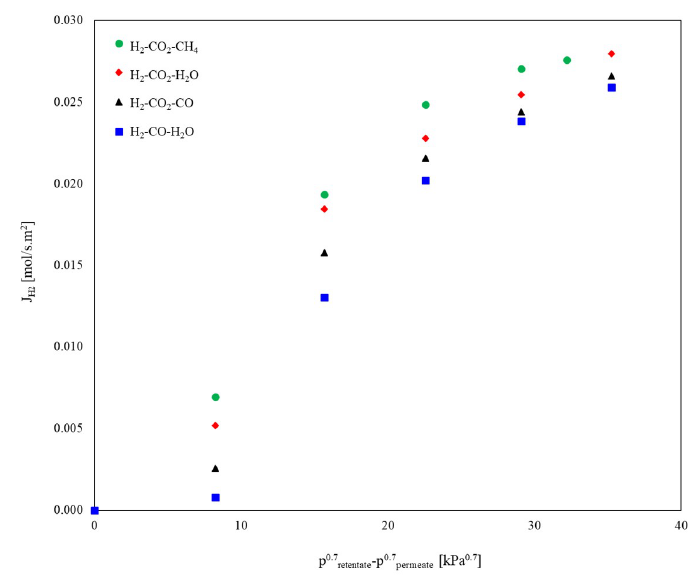
Figure 8. H 2 permeation flux in ternary gas mixtures using Pd/YSZ membrane.